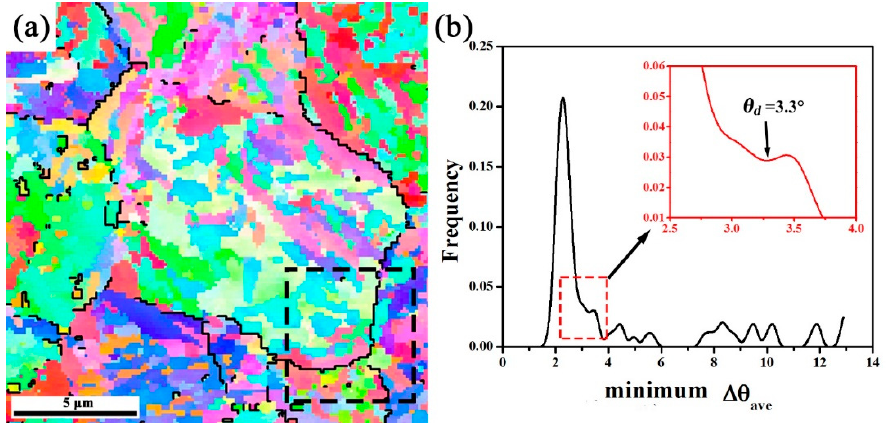
Figure 5. ( a ) IPF map of α with parent γ grain boundaries (PAGB). ( b ) Frequency of the minimum ∆ θ ave of 225 cropped squares from Figure